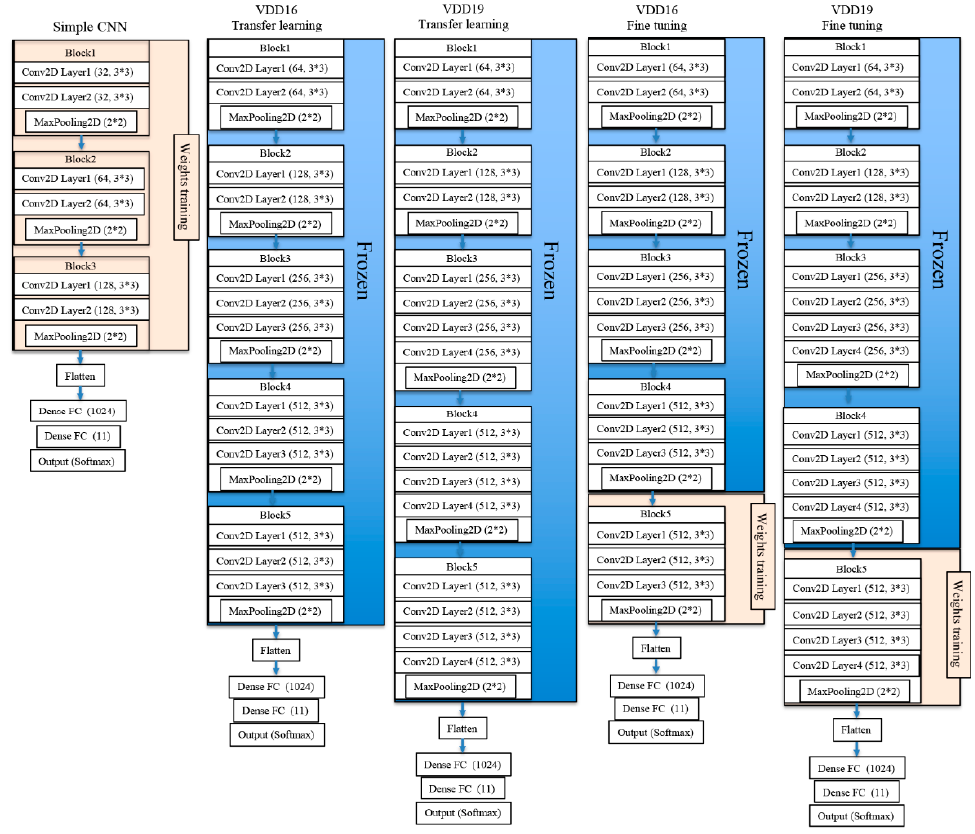
Figure 3. Schematic of the five convolutional neural networks (CNN) architectures.